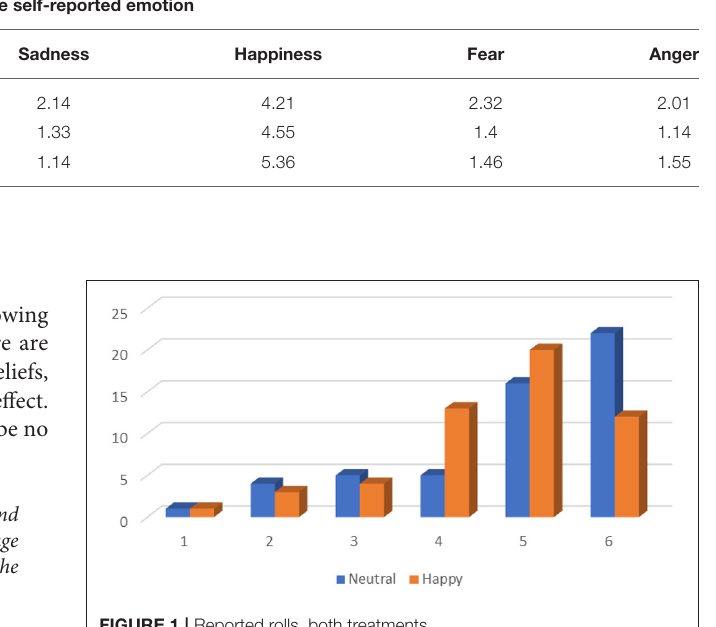
FIGURE 1 | Reported rolls, both